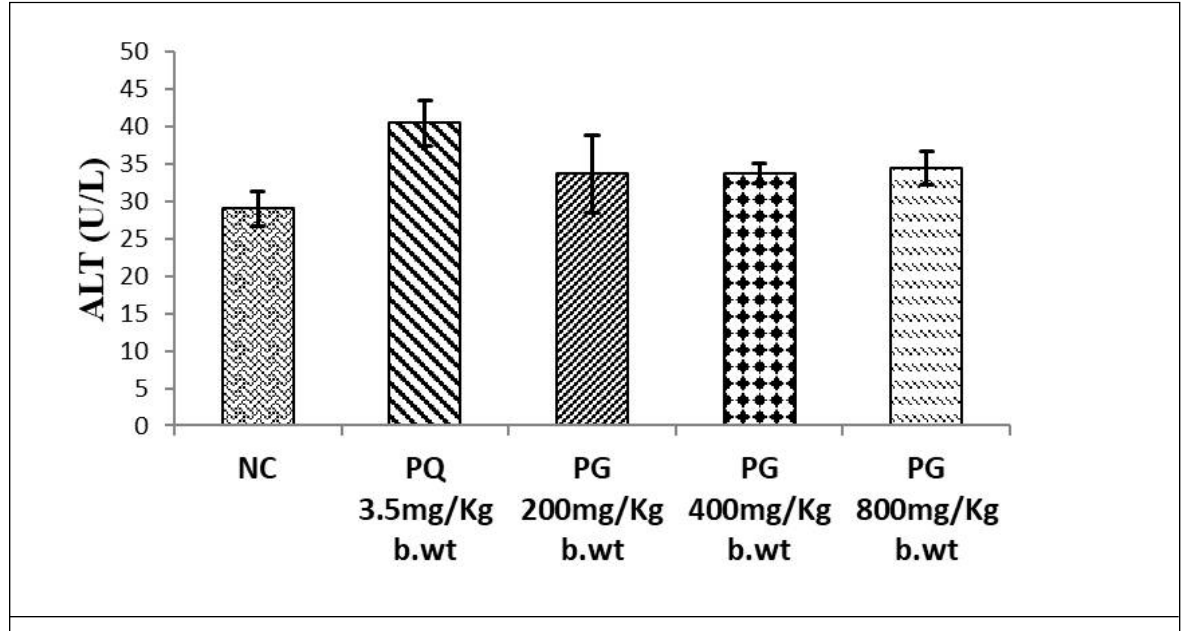
Figure 1: Effect of Psidium guajava leaf extract administration on serum alanine aminotransferase activities of male Wistar albino rats exposed to 3.5 mg/kg b.wt.